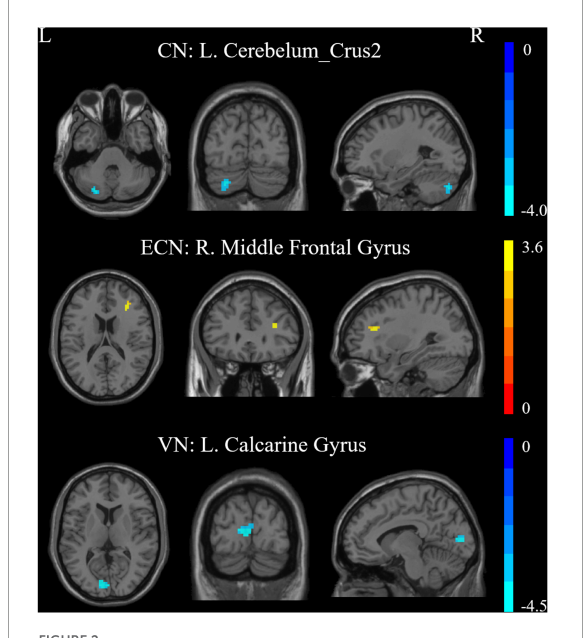
FIGURE2 Intra-network connectivity differences within RSNs in the patients vs. controls. CN, cerebellum network; ECN, executive control network; VN, visual network; R, Right; L, Left.